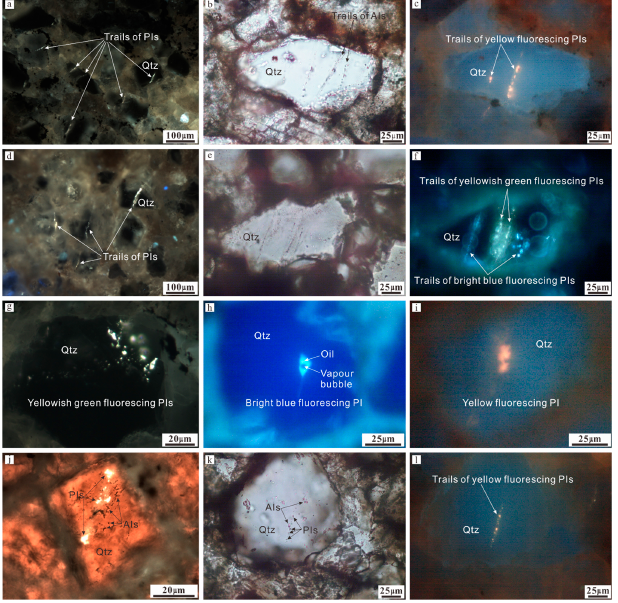
Figure 3. Series of photomicrographs showing the distribution of petroleum inclusions (PIs) and coeval aqueous inclusions (AIs) under the ultraviolet light (UV; a , c , d , f – j , l ) and the transmitted light (TL; b , e , j , k ) from the Es 3 reservoirs in the Minfeng sag, Bohai Bay Basin, East China. ( a ) shows trails of PIs along the healed fractures (both FTQG and FWQG) in quartz (Qtz), from well Feng4, 2748.60 m; ( b , c ) are the same field of view and show trails of yellow fluorescing PIs along the healed frac- tures (both FTQG and FWQG) in quartz, from Feng4, 2748.60 m; ( d ) shows trails of PIs along the healed fractures (both FTQG and FWQG) in quartz, from well Feng112, 2896.40 m; ( e , f ) are the same field of view and show trails of yellowish green and bright blue fluorescing PIs along the healed fractures (both FTQG and FWQG) in quartz, from well Feng14, 2848.20 m; ( g ) shows yellowish green fluorescing PIs along the healed fractures (both FTQG and FWQG) in quartz, from well Feng4, 2748.60 m; ( h ) shows the detail of a petroleum inclusion trapped along FWQG in quartz, with a vapour bubble and bright blue fluorescing oil, from well Feng14, 2848.20 m; ( i ) shows a yellow flu- orescing petroleum inclusion trapped along FTQG in quartz, from well Feng4, 2748.60 m; ( j ) shows trail of yellowish green fluorescing PIs and their coeval AIs along the healed fracture (FTQG) in quartz, UV+TL, from well Feng4, 2748.60 m; ( k , l ) are the same field of view and show trail of yellow fluorescing PIs and coeval AIs along the healed fracture (FWQG) hosted in quartz, from well Feng4, 2748.60 m.